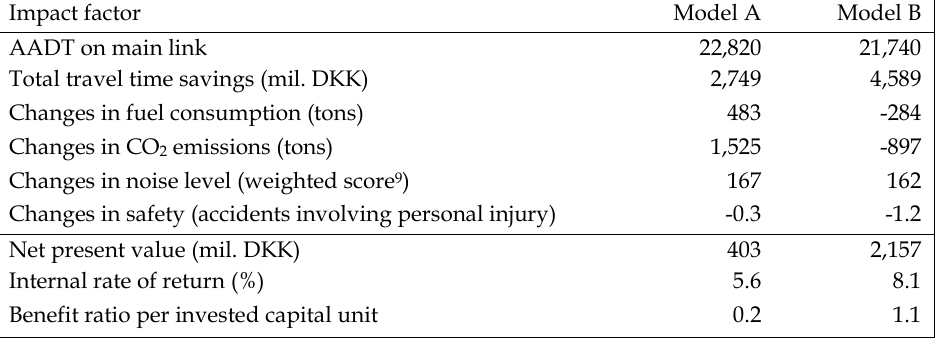
Table 1. Estimated main traffic-related impacts of the proposed Nordhavnsvej, based on transport model forecasts with induced traffic included (Model A) and ignored (Model B). Source: Tetraplan